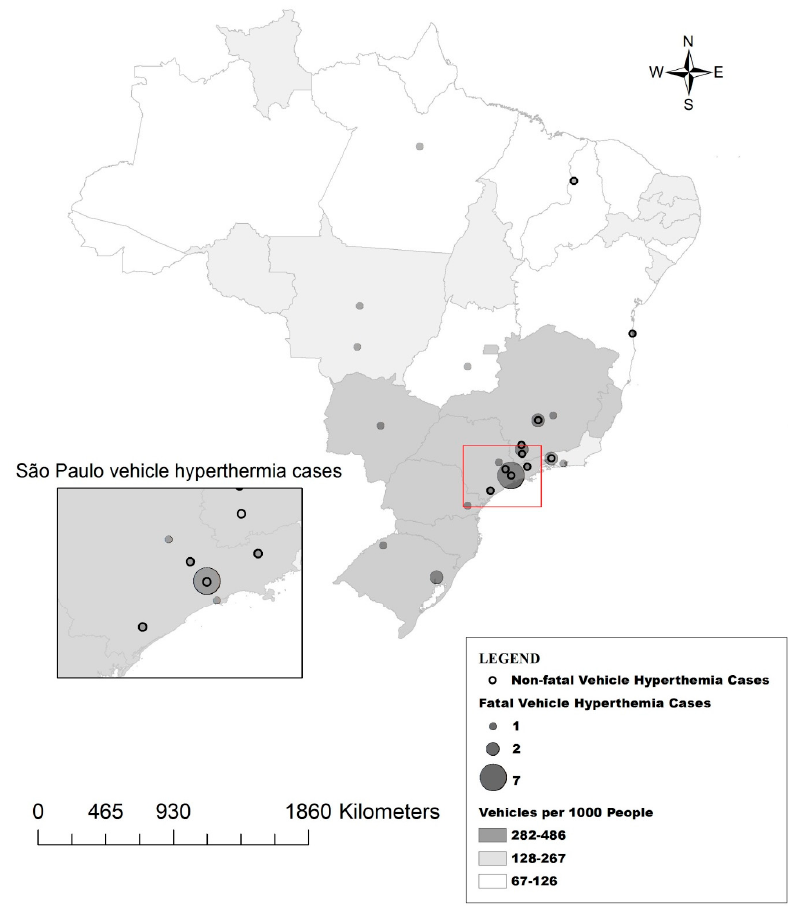
Figure 2. Locations of children left unattended in motor vehicles. The red box cover the area around the city of São Paulo, which is shown at higher resolution in the box to the left. Vehicles per 1000 people is categorized by thirds.